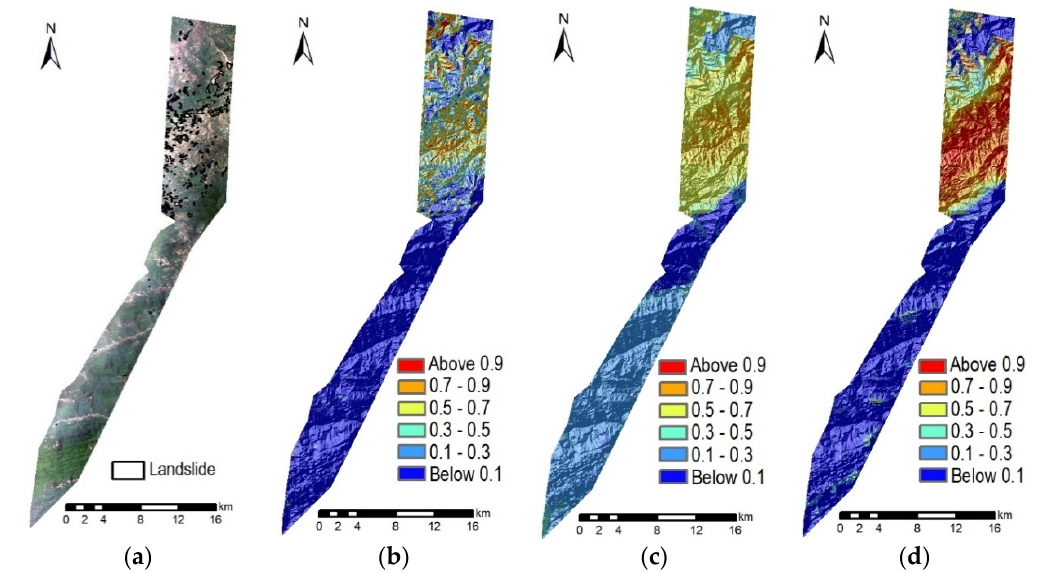
Figure 17. LSM results on test dataset 2. ( a ) Airborne imagery and landslides distribution of test area 2; ( b ) U ‐ net modeled LSM; ( c ) LR modeled LSM; and ( d ) SVM modeled LSM.